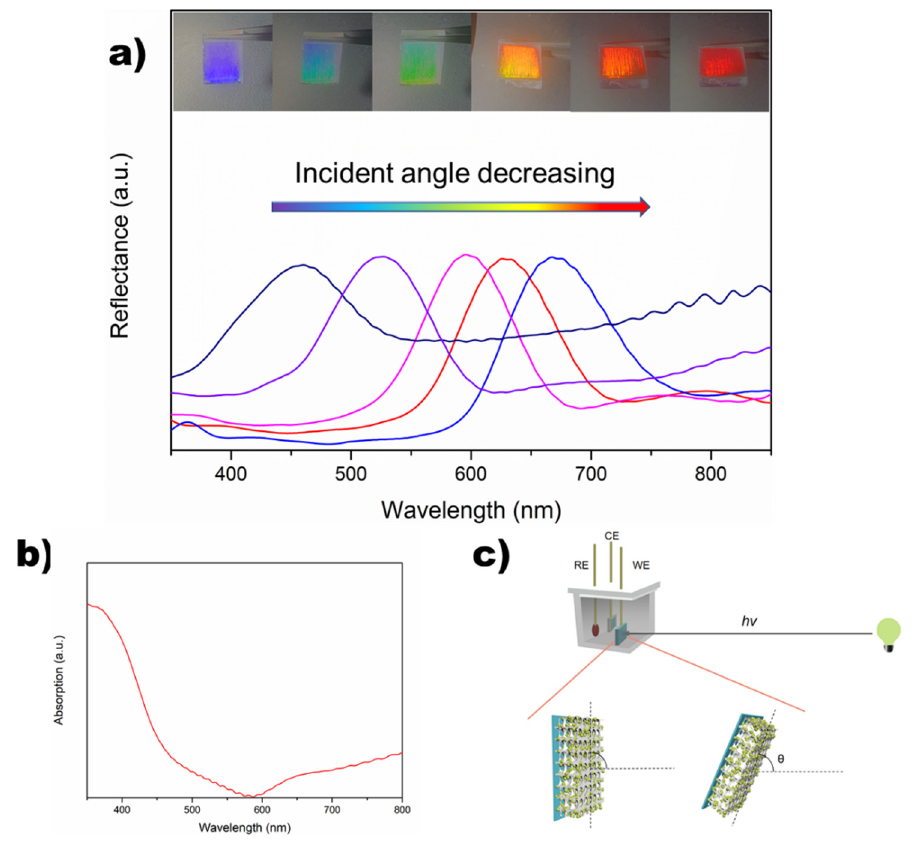
Figure 2. ( a ) DRS and digital photographs of a PC FTO (pore size of ca. 300 nm) photoelectrode under different incident angle illumination; the PSB is expressed as the reflectance peaks; ( b ) the absorption spectra of CdS nanoparticles; ( c ) the setup of CdS-loaded PC FTO photoelectrode in the PEC cell.